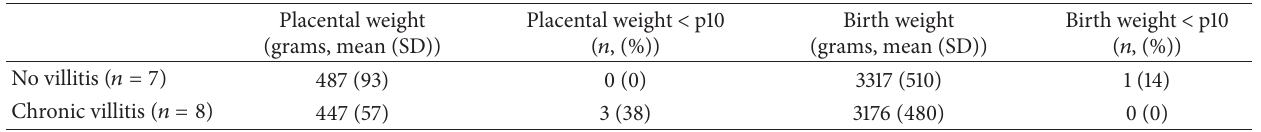
Table 4: Placental weight, number of placentas with weight < p10, birth weight, and number of neonates with birth weight < p10 divided by the absence or presence of villitis. Placental weight (grams, mean